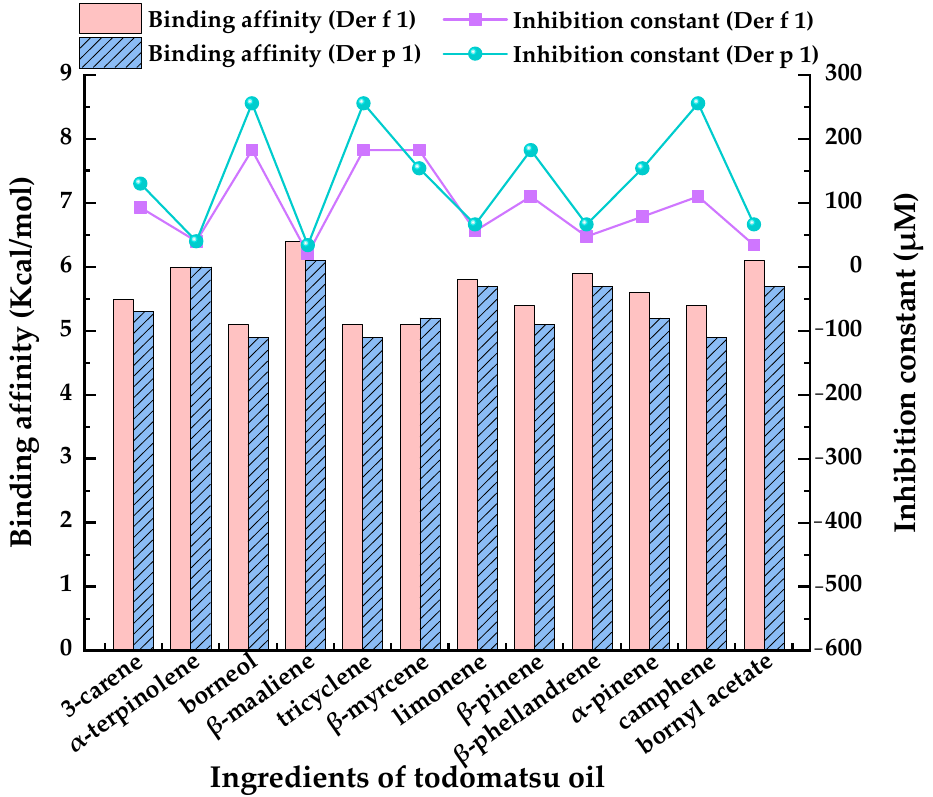
Figure 5. Binding affinity (BA) scores and inhibition constants ( Ki ) of ingredients-of-todomatsu oil on allergens Der f 1 and Der p 1.